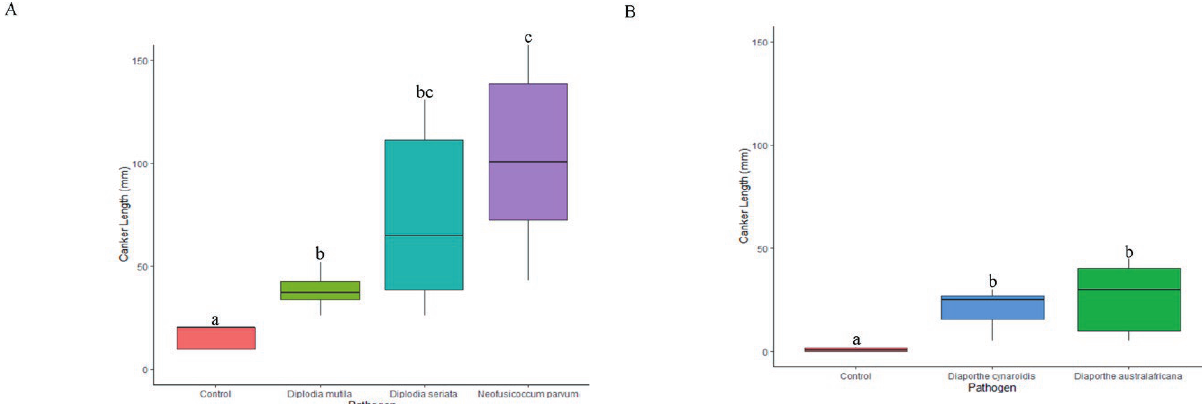
Figure 5. Average canker length (mm) after 12 weeks caused by three Botryosphaeriaceae species ( A ) and two Diaporthe species ( B ) on walnut stems inoculated with mycelial plugs. Bars topped with different letters indicate treatment means that are significantly different for Botryosphaeriaceae and Diaportheaceae ( P < 0.05)